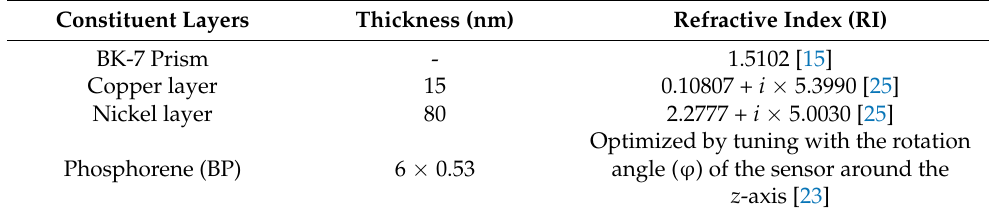
Figure 1. Proposed SPR sensor configuration in attenuated total internal reflection mode. Table 1. Proposed sensor’s thickness and RIs of constituent layers at the characteristic wavelength at λ = 830 nm.